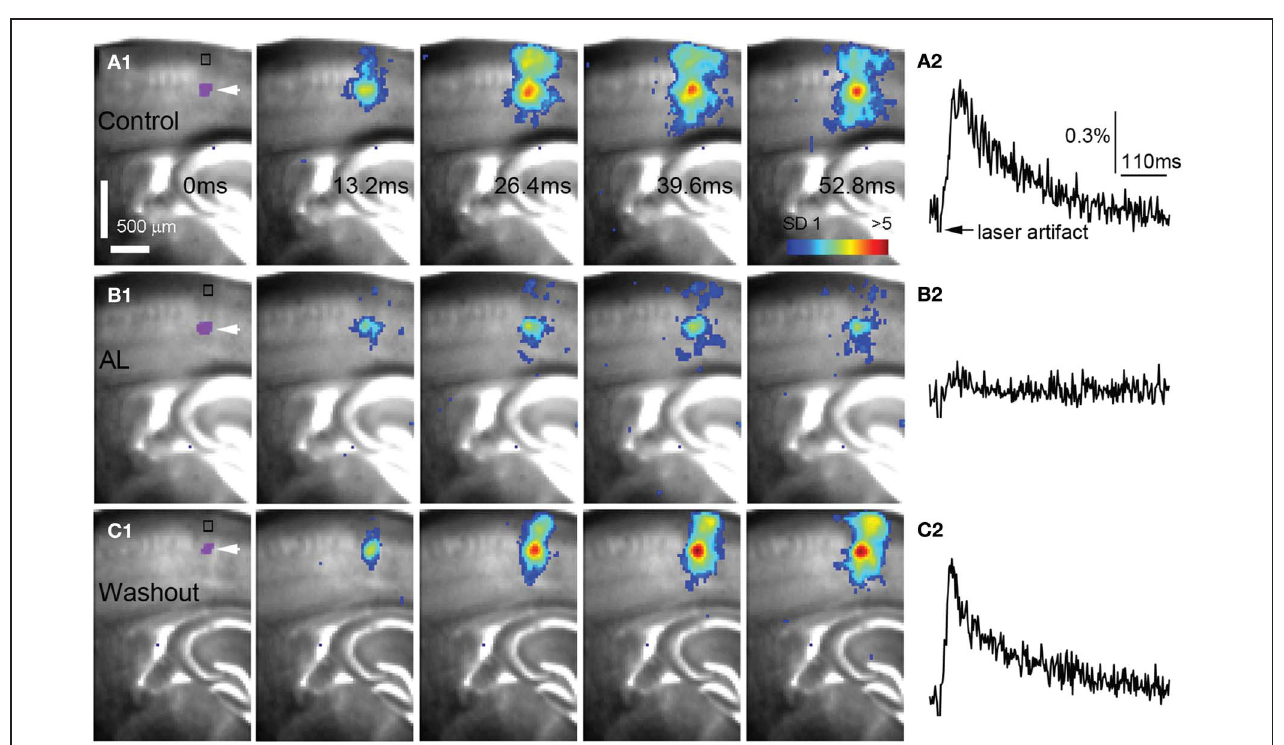
FIGURE 4 | AlstR-mediated inhibition of excitatory neuronal population activity in an Emx1-Cre: AlstR mouse slice. (A1) Time series data of VSD imaging of photostimulation-evoked activity in S1 cortex in normal ACSF. The color scale codes VSD signal amplitude expressed as standard deviation (SD) multiples above the mean baseline. The site of photostimulation between layers 4 and 5a can be identified by the laser excitation artifact (purple) in the first frame, which is also indicated by the white arrowhead. Color-coded excitatory activity is superimposed on the background slice image. (A2) The time course of VSD signal (in the percent change of pixel intensity [ (cid:3) I / I % ] ) from the region of interest (ROI) indicated by the small rectangle in the first